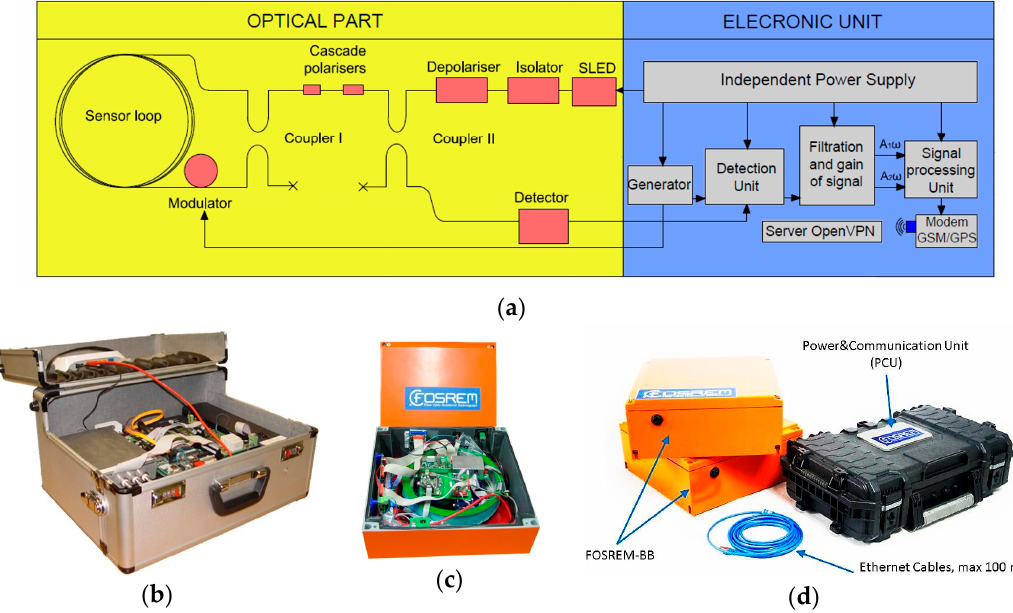
Figure 10. FOSREM: ( a ) general scheme of the system; ( b ) view of FOSREM-SS; ( c ) view of FOSREM-BB; ( d ) multi-sensor synchronous measuring system based on FOSREM-BB.